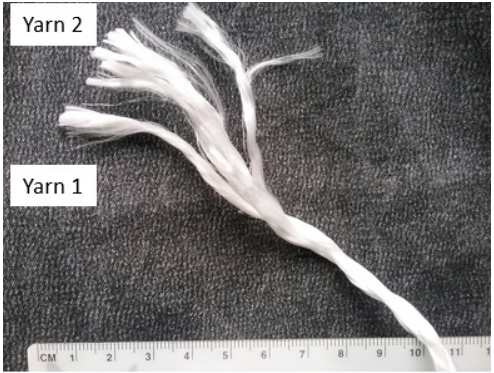
Figure 2. Image of double hybrid yarn with intact Yarn 1 (left) and disassembled Yarn 2 (right).